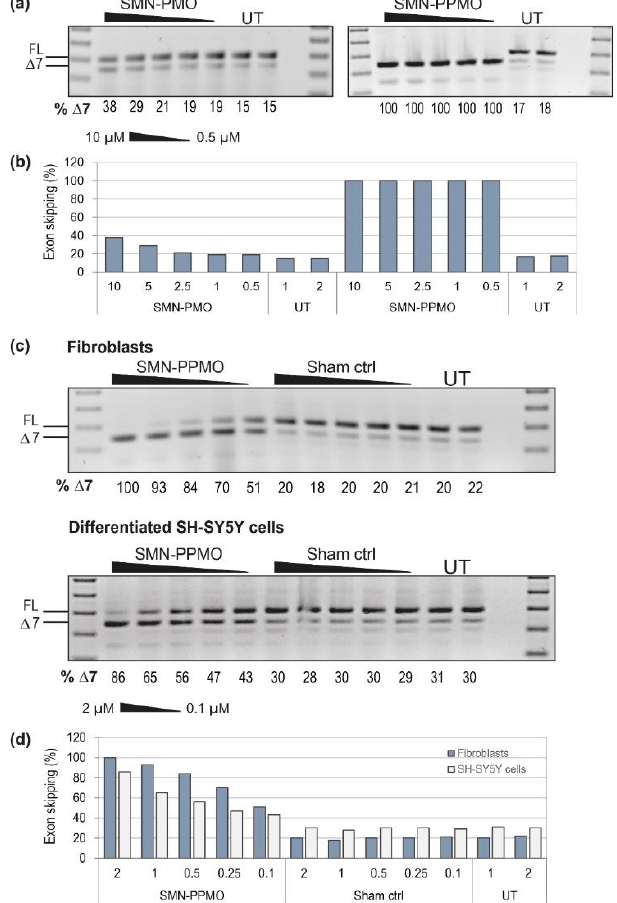
Figure 3. Analysis of AO chemistry and delivery after transfection into fibroblasts and neuronal cells, showing ( a ) RT-PCR across SMN transcripts following transfection with exon skipping PMO and PPMO into fibroblasts at 10, 5, 2.5, 1 and 0.5 µ M; ( b ) graphical representation of densitometry as in ( a ); ( c ) RT-PCR of SMN transcripts in fibroblasts and SH-SY5Y cells, following transfection with the SMN-PPMO at 2, 1, 0.5, 0.25 and 0.1 µ M; and ( d ) graphical representation of densitometry as in ( c ). The full length transcript (FL, 404 bp) and exon 7 skipped product (delta-7( ∆ 7), 350 bp) are indicated by the lines to the left of the gel, and the percentage of ∆ 7- SMN transcript, as determined by densitometry is shown below each lane for comparison to controls and untreated (UT) cells. A 100 bp size marker was used for size comparison and a no template RT-PCR control (NTC) was loaded in the final